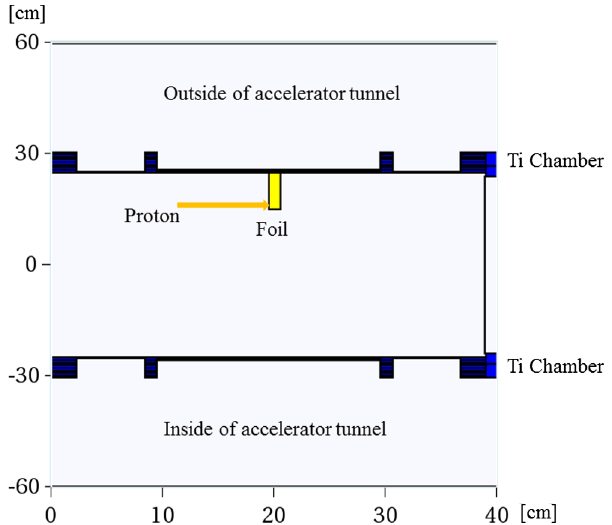
FIG. 1. Geometry of MARS calculation. In this figure, the charge exchange foil (yellow) is expanded to clarify its position.